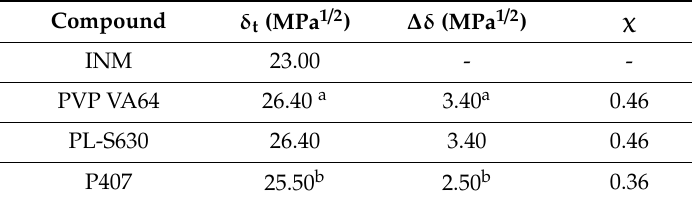
Table 2. Calculated solubility parameters using Hansen solubility parameters ( δ ) and drug–polymer interaction factor ( χ ).